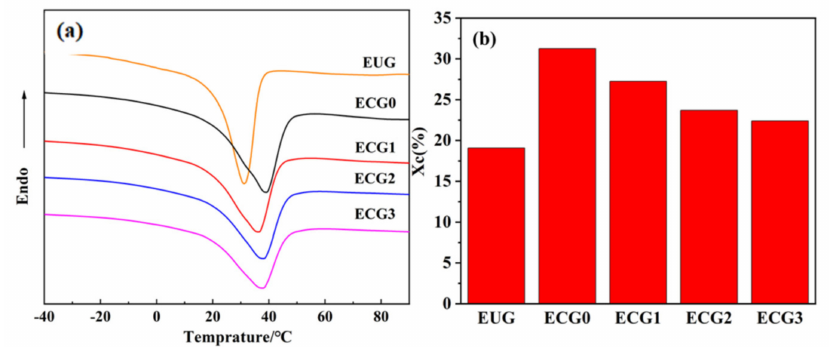
Figure 9. ( a ) DSC curves of CNT/GNP/EUG composites, ( b ) the crystallinity (Xc) of CNT/GNP/EUG